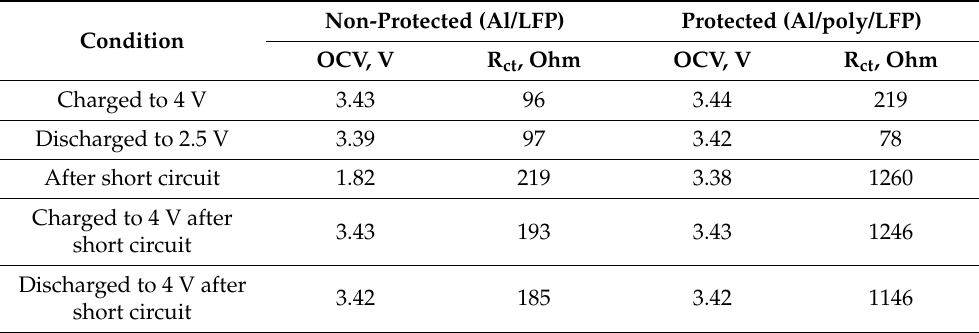
Table 1. Charge transfer resistances of non-protected (Al/LFP) and protected (Al/poly/LFP) cells at different conditions.